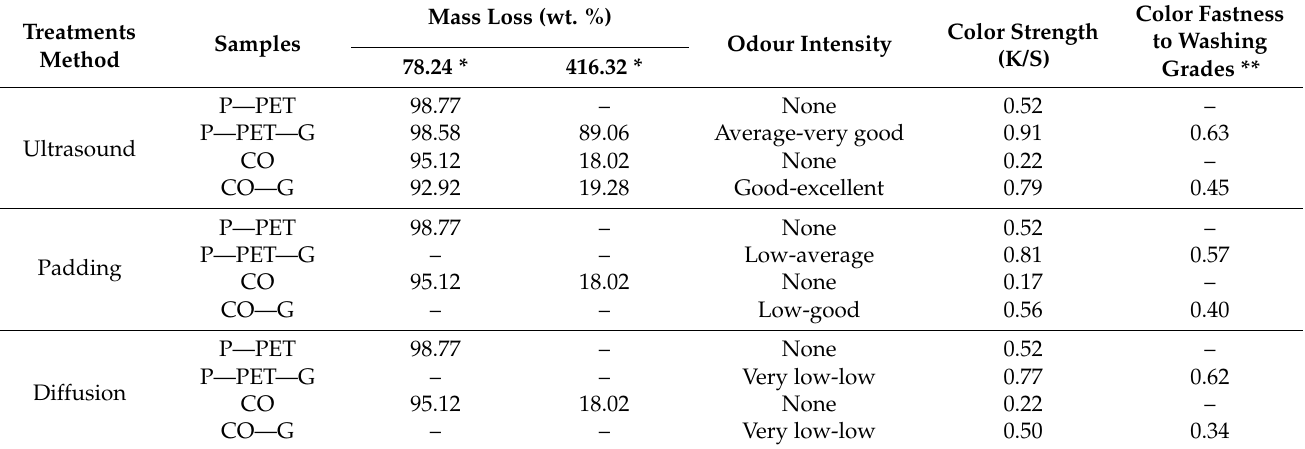
Table 4. Main features of cotton and polyester fabrics and their modified